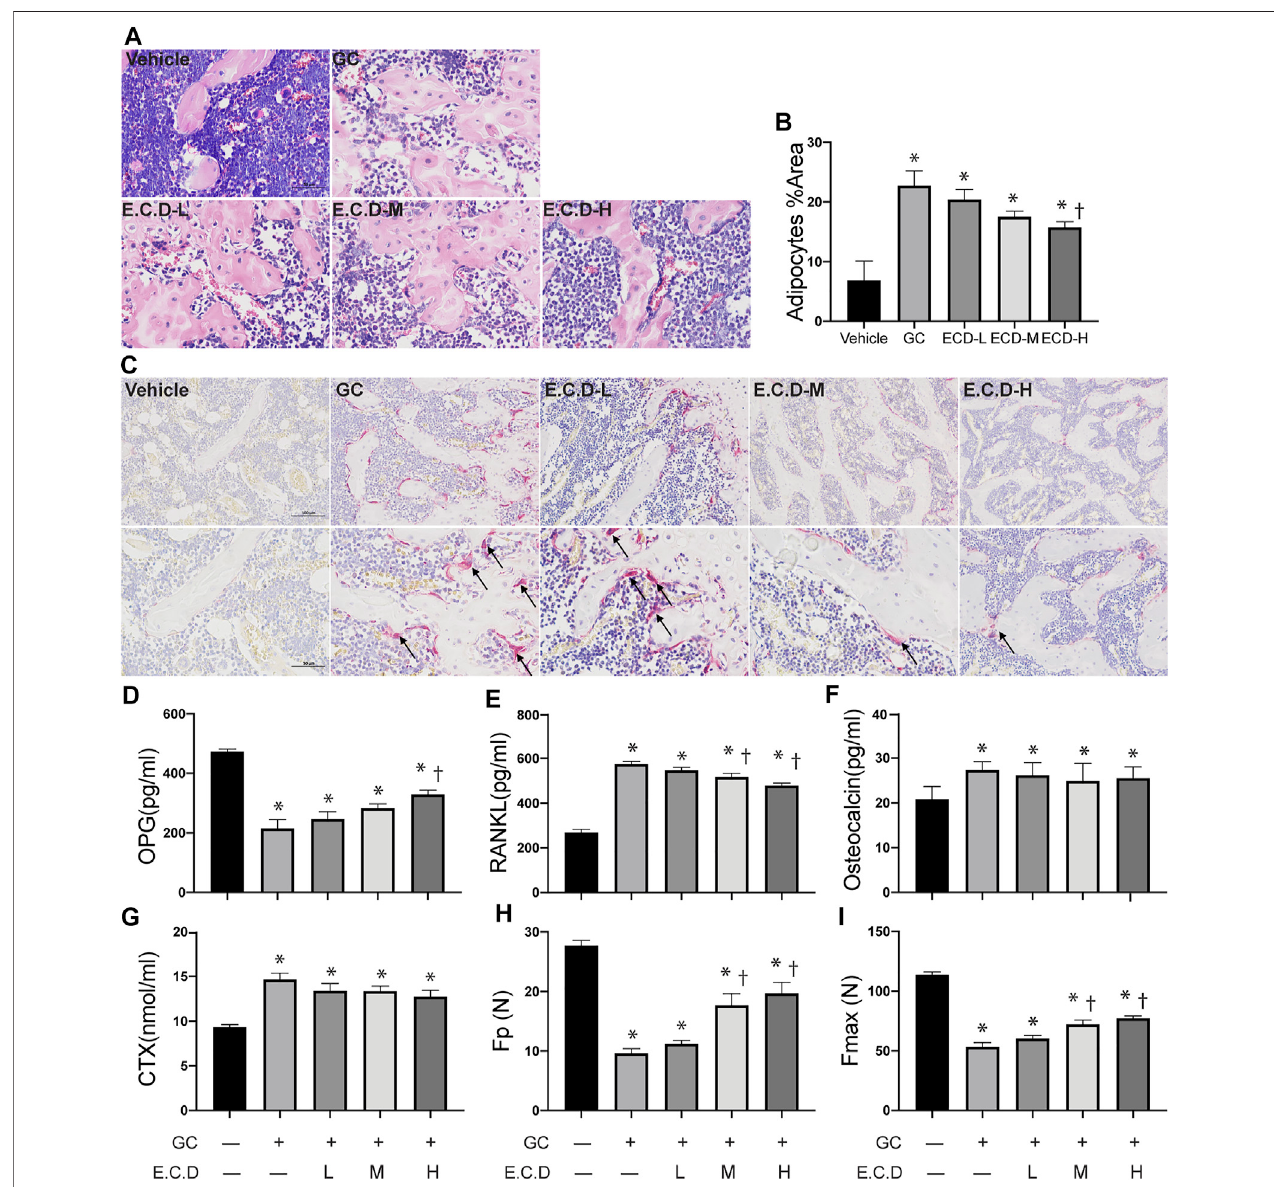
FIGURE 2 | E.C.D. extracts restored the bone marrow structure and regulated cytokine of bone resorption and regeneration. (A) H&E staining was performed with femur of rats in fi ve groups: Vehicle group (left upper panel), GC group (middle upper panel), B.C.D. – L group (left lower panel), B.C.D. – M group (middle lower panel), and B.C.D. – H group (right lower panel). (B) The quantitative adipocytes area in bone marrow for fi ve groups, n = 3 in each group. (C) TRAP staining was assessed for fi ve groups, upper panel is X200 magni fi cation, lower panel is X400 magni fi cation. The black arrow pointed to TRAP positive osteoclasts. (D – G) The OPG, RANKL, osteocalcin, and CTX level in rats ’ serum were measured 8 weeks after GC administration, n = 8 in each group. (H,I) The Fp and Fmax of bone were assessed, n = 8 in each group. Data were analyzed as mean ± SEM, * vs. Vehicle group (GC – E.C.D. – ), † vs. GC group (GC + E.C.D. – ), p <